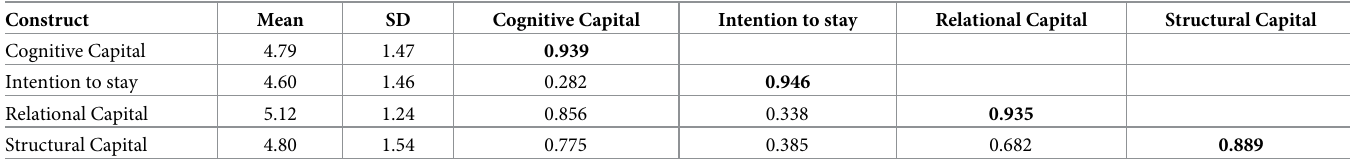
Table 4. Assessing discriminant validity.